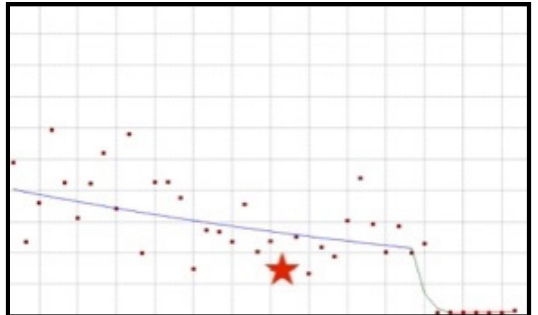
Figure 7. A schematic graph of the frequency of use of cranberry derivatives in the respective quarters in the period from the first quarter of 2012 to the fourth quarter of 2021. The star denotes the moment of publication of the resolution concerning the ingredient. The height of placement of the symbol reflects the level of use of the ingredient. Cranberry derivatives (Figure